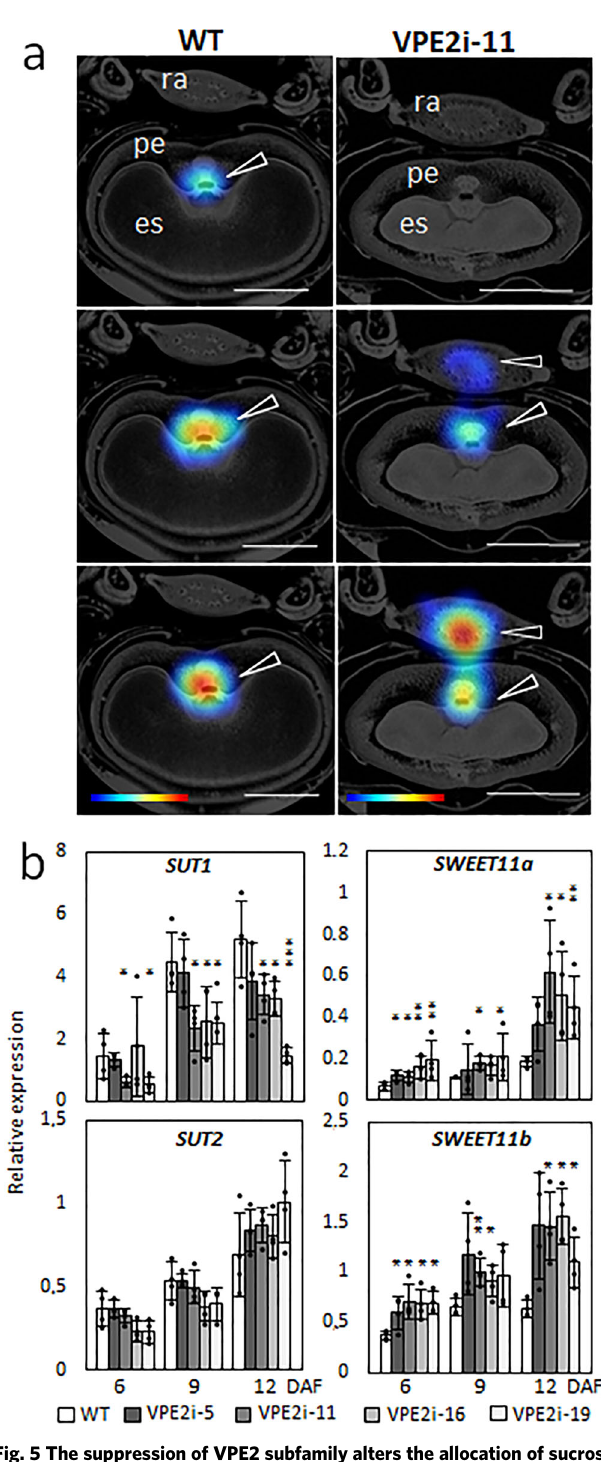
Fig. 5 The suppression of VPE2 subfamily alters the allocation of sucrose in the grain. a The distribution of 13 C labeled sucrose, as captured by MRI after 1 (above), 3 (middle), and 8 h (bottom) at 9 DAF. The sucrose concentration is indicated by the color-coded bar (below) with max (min) values in red (blue). b The abundancies of SUT1 , SUT2 , SWEET11a, and SWEET11b transcripts in the developing grains of WT and RNAi-VPE2 transgenic lines. Data shown as the mean ± SD ( n = 4). *, **, ***: means differ at, respectively, P < 0.05, < 0.01, and < 0.001. Bars = 1 mm in a . Abbreviations: DAF days after fl owering, es endosperm, pe pericarp, ra